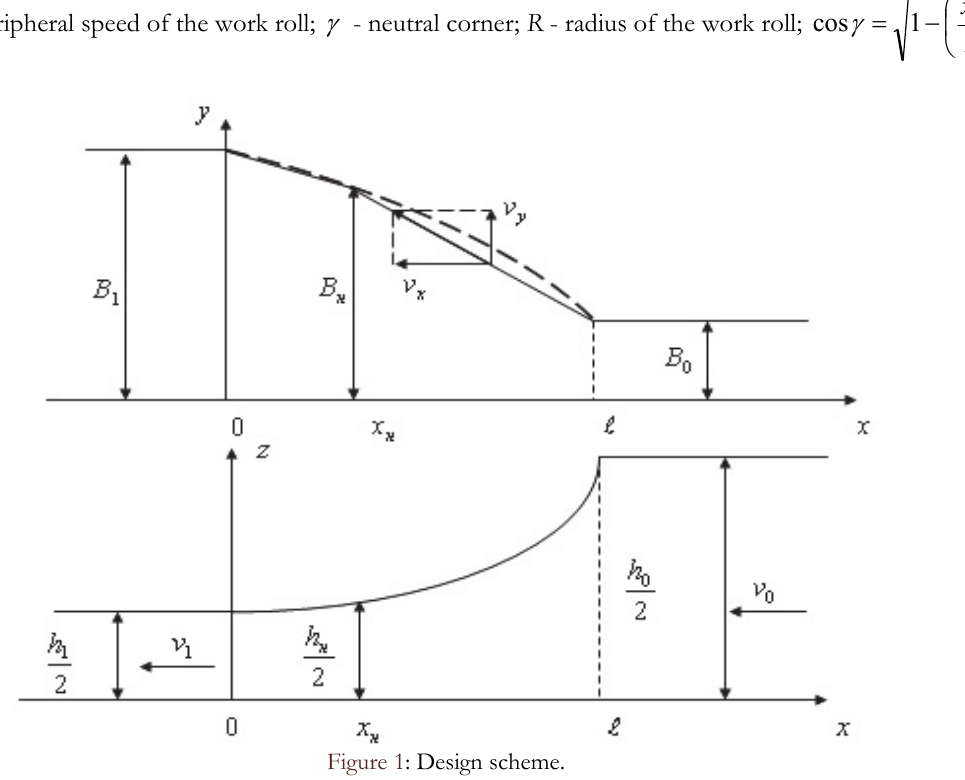
Figure 1: Design